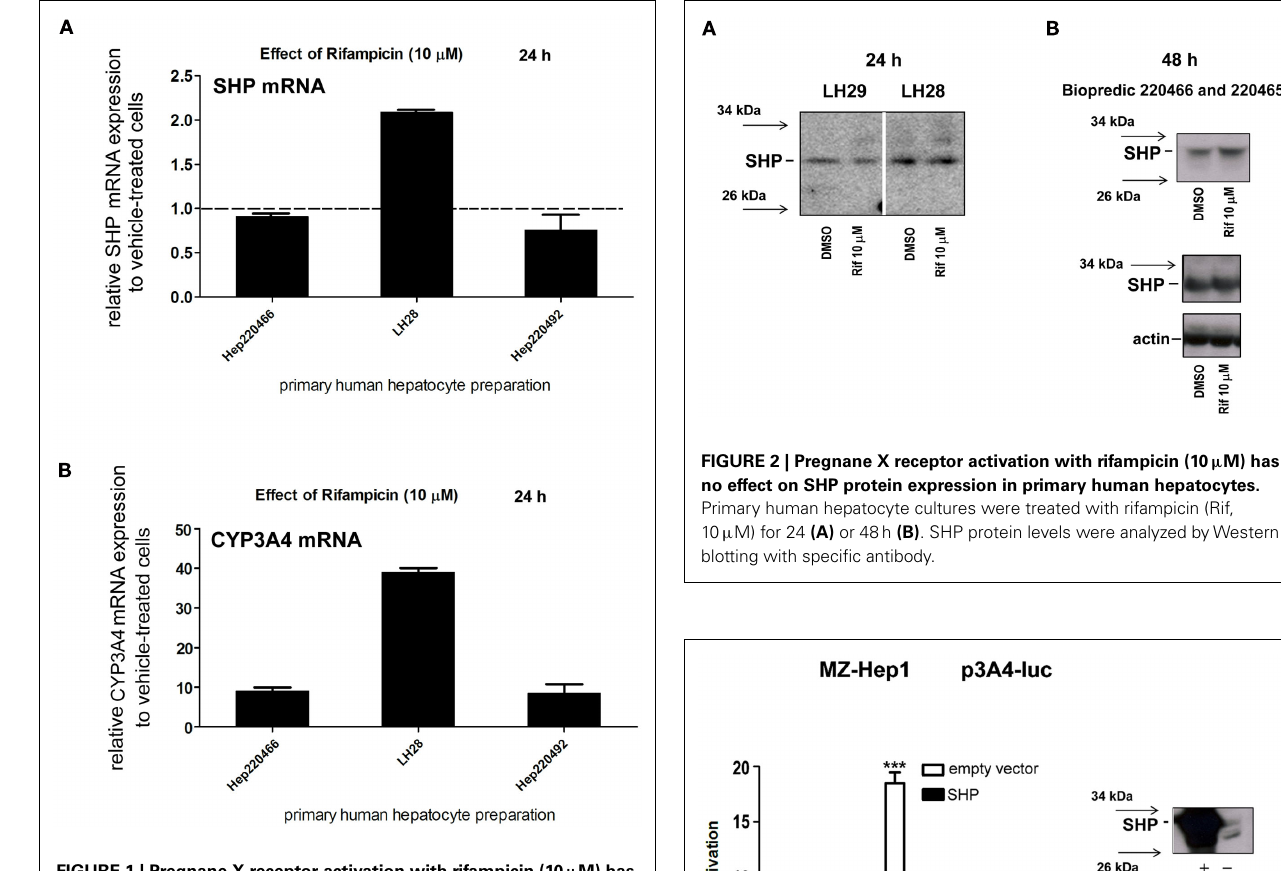
FIGURE 1 | Pregnane X receptor activation with rifampicin (10 μ M) has variable effects on SHP mRNA expression in primary human hepatocytes. Primary human hepatocyte cultures ( HEP220466, LH28, HEP220492) were treated with rifampicin (Rif, 10 μ M) for 24h.Total RNA was isolated, and mRNA levels were analyzed by qRT-PCR.The effects of rifampicin (10 μ M) on the mRNA levels of SHP (A,B) CYP3A4 genes were normalized to housekeeping HPRT mRNA and are presented as the relative mRNA expression compared to control vehicle (DMSO)-treated cells (set to 1).